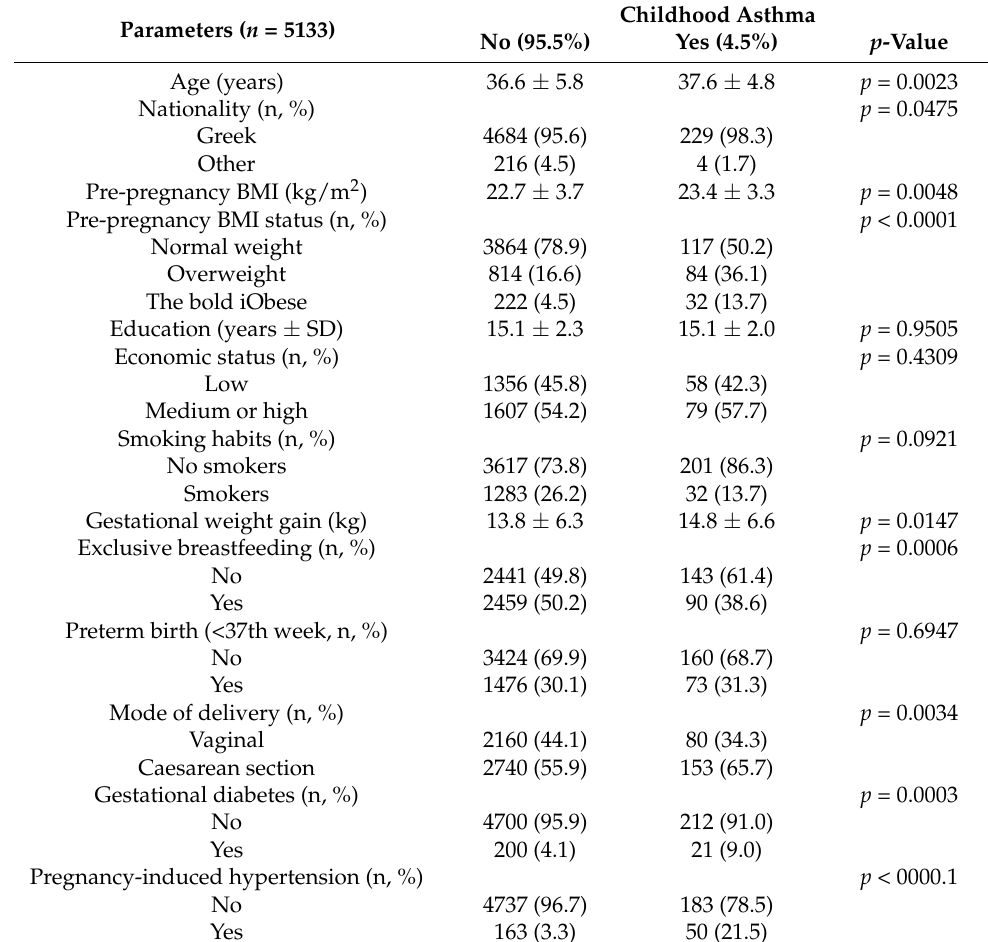
Table 1. Associations of childhood asthma with maternal sociodemographic, anthropometric and prenatal and perinatal